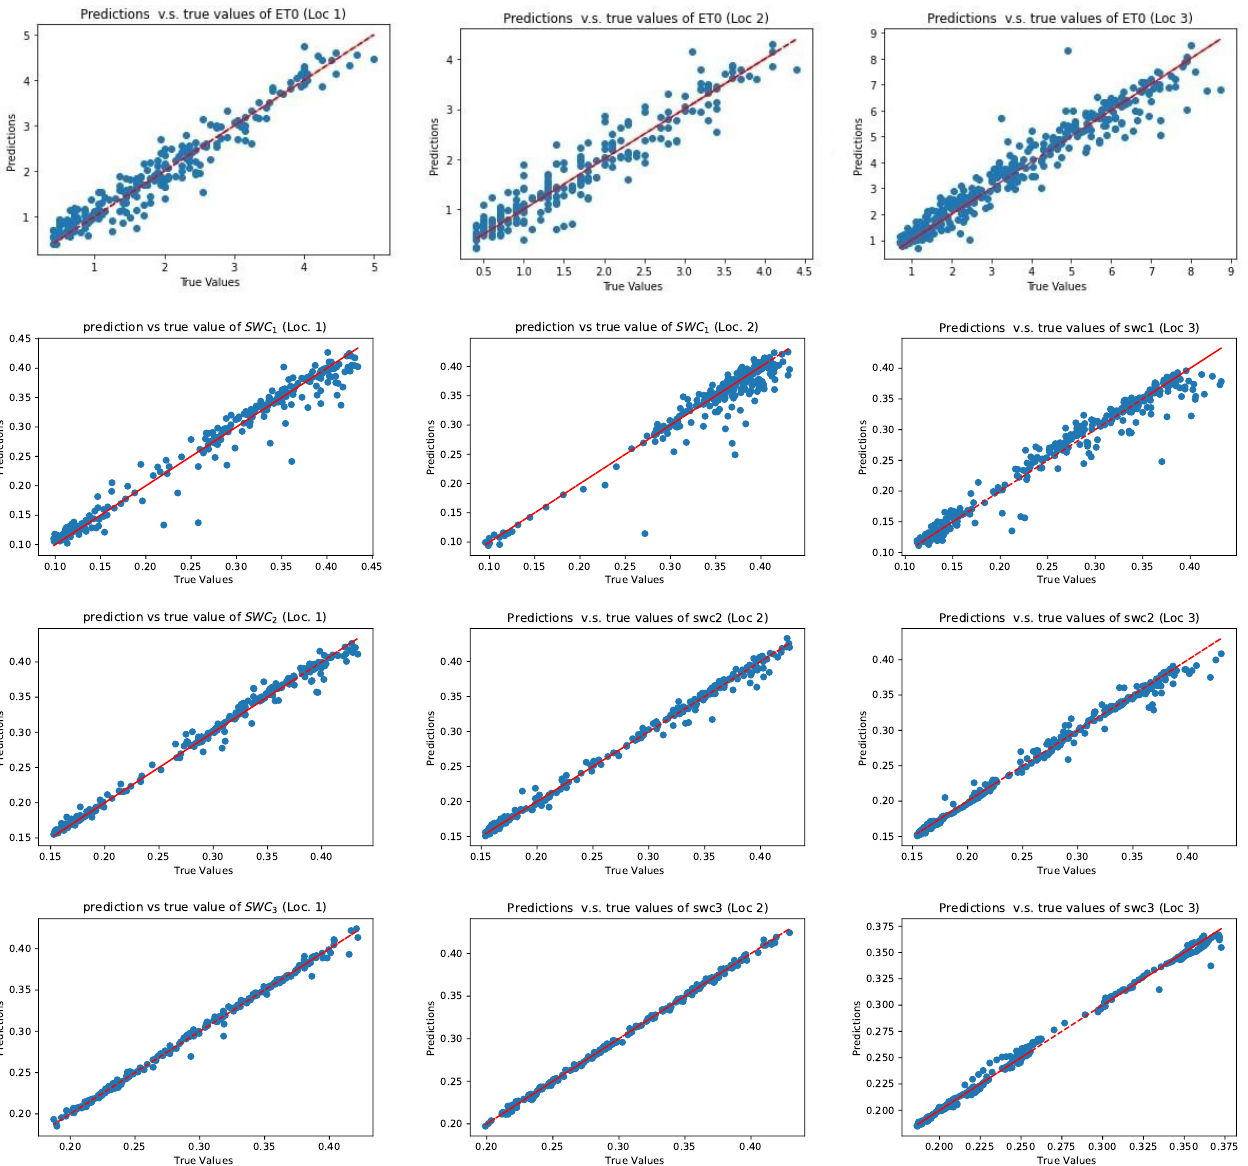
Figure 9. True values vs. Predicted values. The x-axis indicates true values, and the y-axis indicates prediction values by